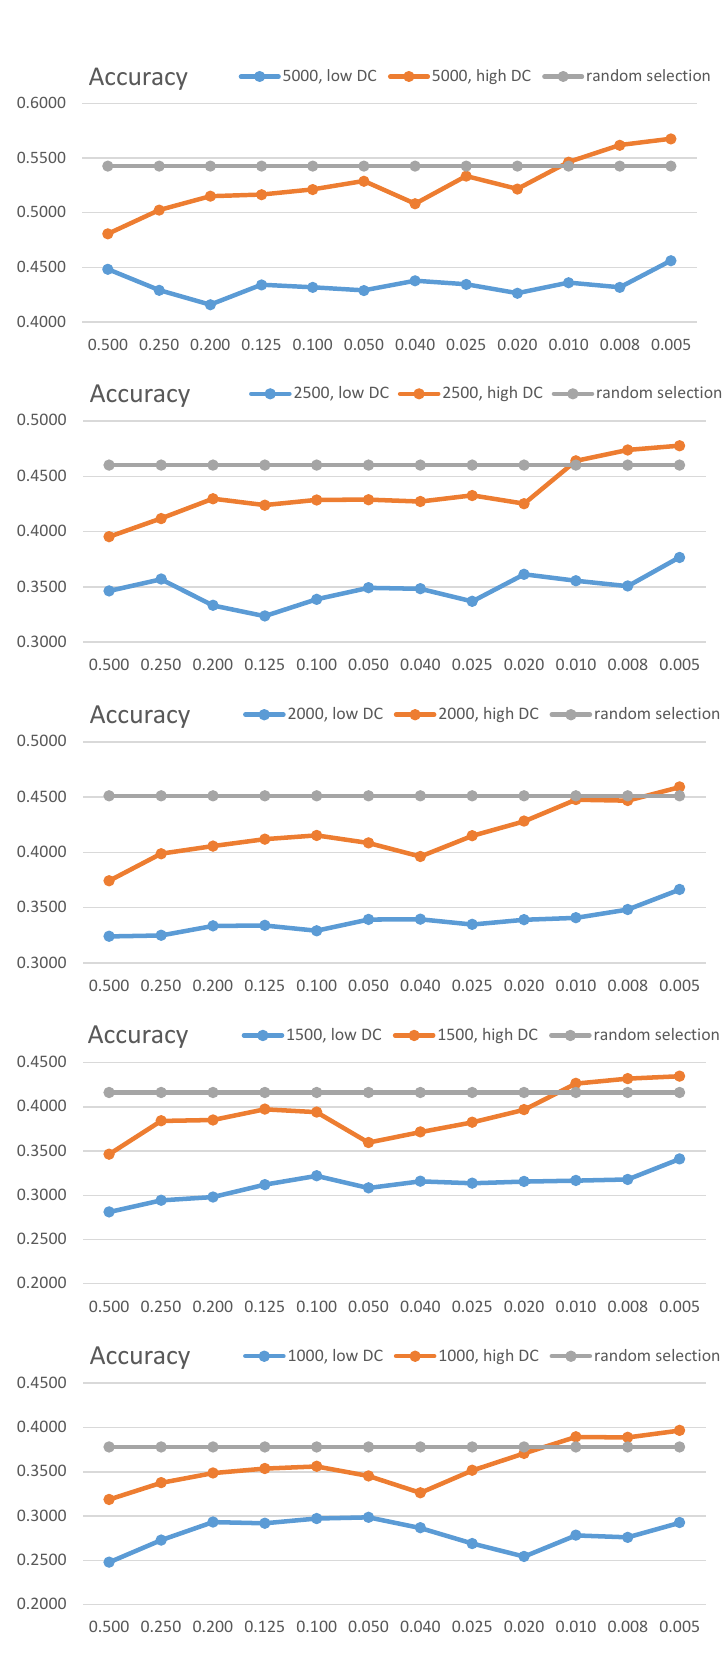
Figure 7. Classification accuracy on distribution consistency and data size (the x-axis represents the value of r g ).